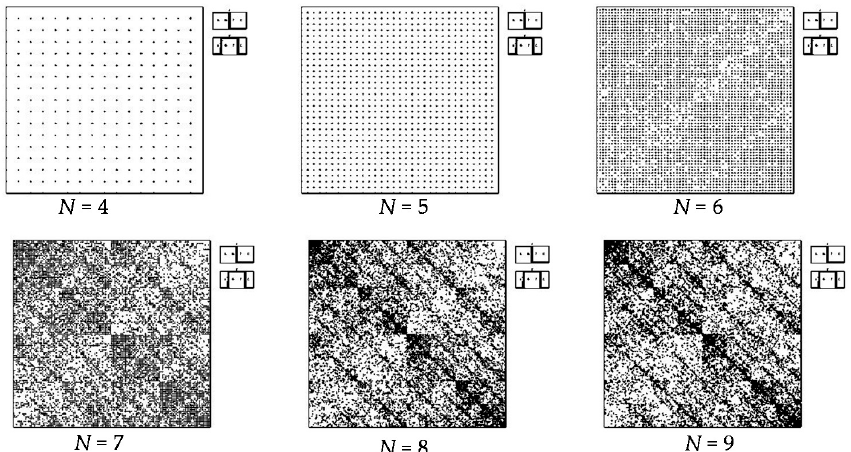
Figure 6. Examples of patterns for the sequence Fistulifera sp. JPCC DA0580 chloroplast, complete genome in cases of its divisions into N -plets with N = 4, 5, 6, 7, 8, 9.